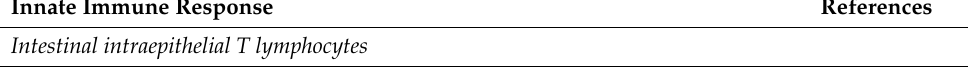
Table 1. Cont. Innate Immune Response Intestinal intraepithelial T